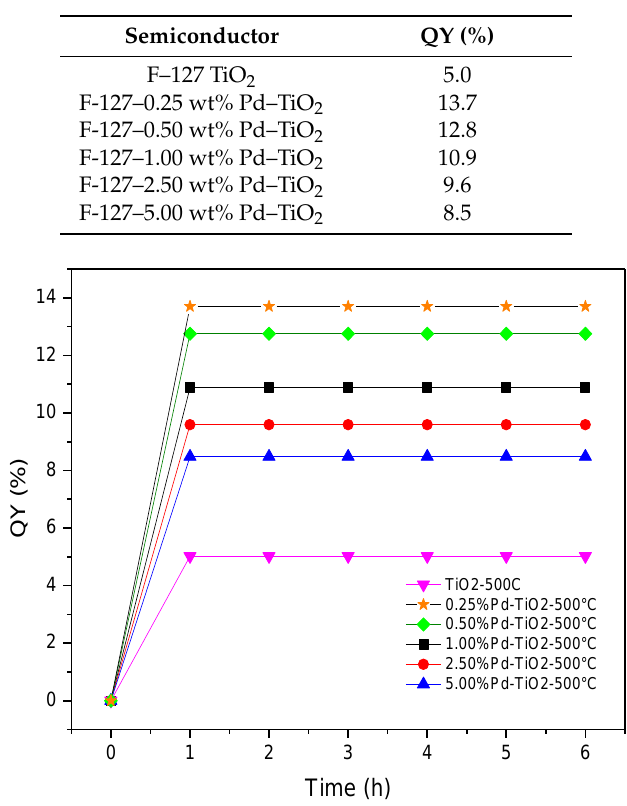
Table 5. Quantum yield (QY) for the Pd–TiO 2 photocatalyst when using 0.15 g/L. All reported data are average values of three repeats.